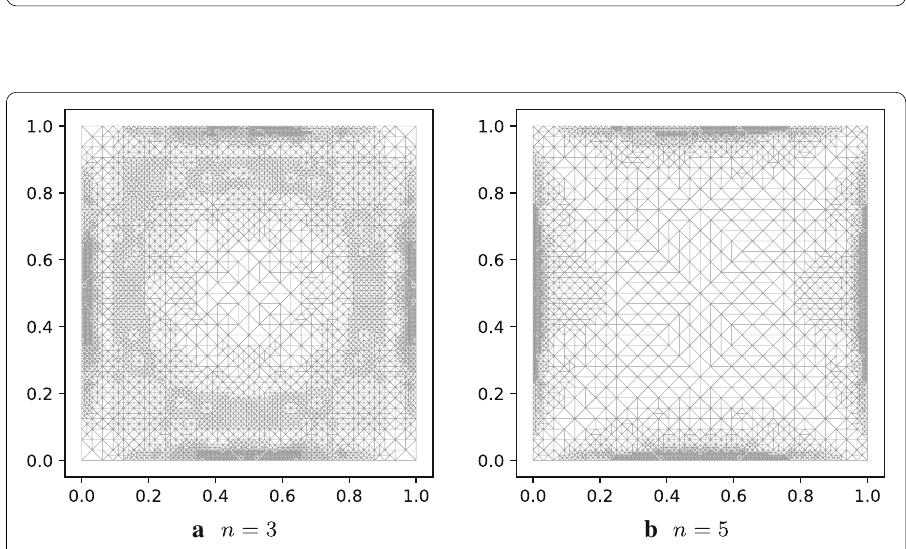
Fig. 9 Refined meshes for the triple laminate for different thickness discretization levels